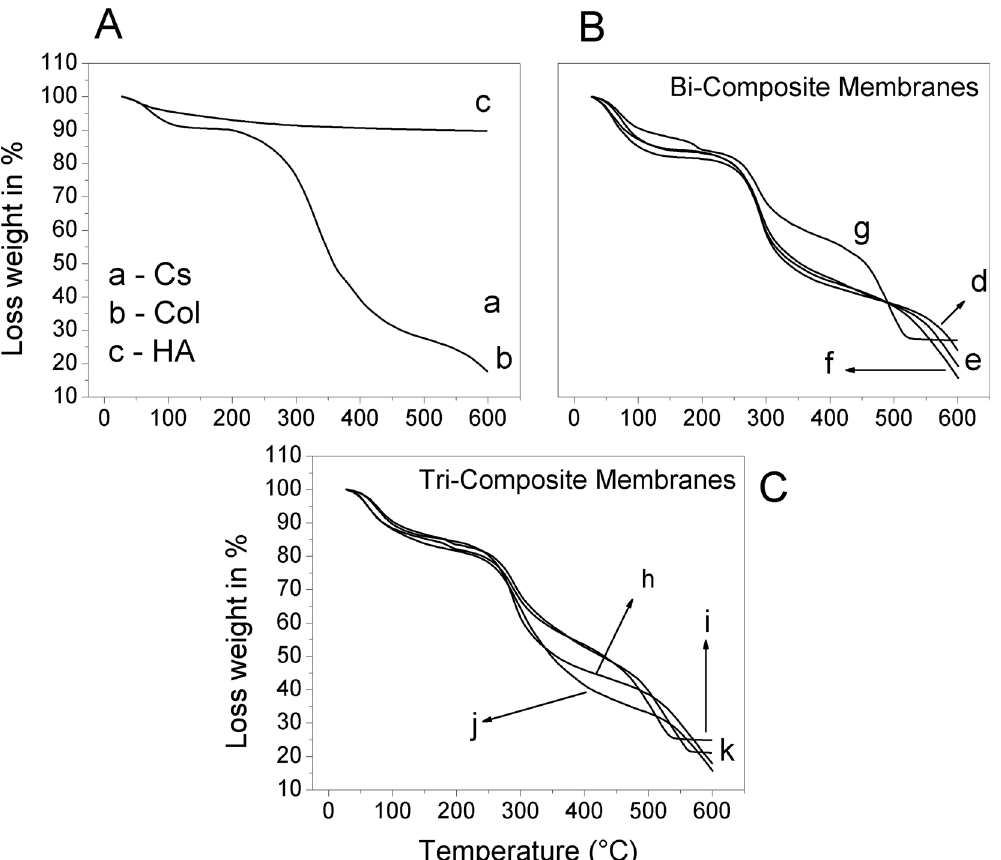
Fig. 7 TGA analysis of the different membranes: A a Chitosan (Cs). b Collagen (Col). c Hydroxyapatite(HA). B Bi-composite d BC1. e BC2. f BC3. g BC4. C Tri-composite h TC1. i TC2. j TC3. k